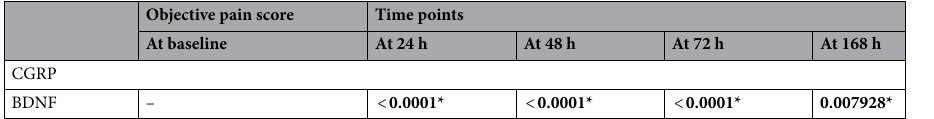
Table 6. p -values of comparison between objective pain score – molecular salivary pain biomarkers namely CGRP and BDNF over time points. Significant values are in [bold]. * p <